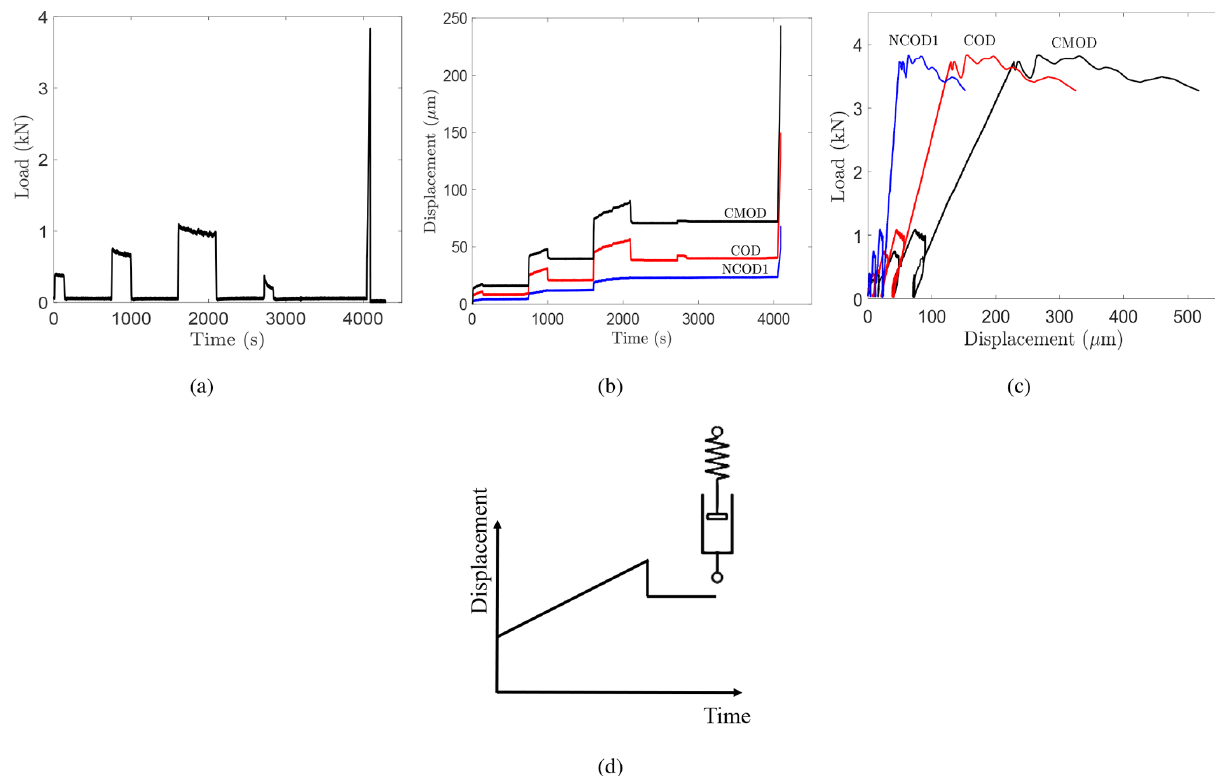
Figure 7. Experimental results for RP16. (a) Load at the crack mouth; see Fig. 1. (b) Displacement–time records. (c) Load–displacement record. (d) Typical response of a Maxwell model, consisting of a nonlinear spring and nonlinear dashpot, to a constant load step.